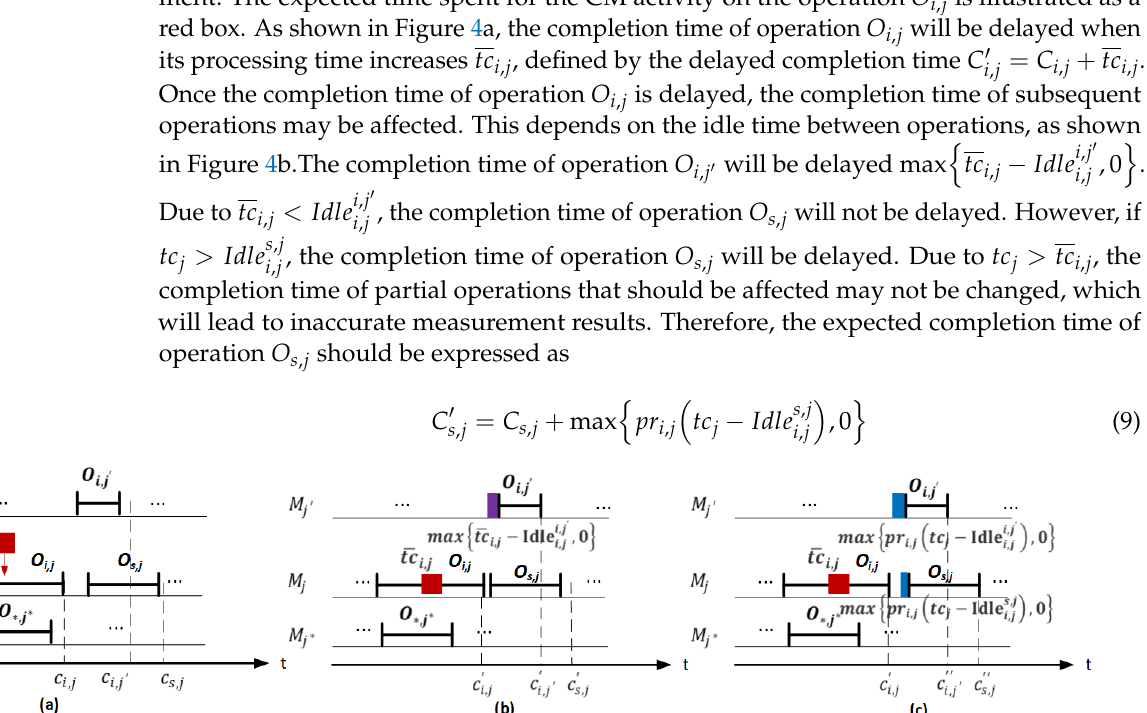
Figure 5. The Gantt chart for n = 3, m = 2. In chain 1, i.e., 𝑂 1,1 → 𝑂 3,1 → 𝑂 3,2 , when the failure occurs in the operation 𝑂 1,1 , it may first affect the completion time of operation 𝑂 3,1 . As shown in Figure 6b, the expected completion time of 𝑂 3,1 is denoted as 𝐶 3,1 Ⅰ = 𝐶 3,1 + max { 𝑝𝑟 1,1 ( 𝑡𝑐 1 − 𝑖𝑑𝑙𝑒 1,13,1 ) , 0 } . The fail- ure will continue to propagate along the chain of constraints, and the operation 𝑂 3,2 will be affected. The expected completion time of 𝑂 3,2 is 𝐶 3,2 Ⅰ = 𝐶 3,2 + max { 𝑝𝑟 1,1 ( 𝑡𝑐 1 − 𝑖𝑑𝑙𝑒 1,13,2 ) , 0 } . When the failure occurs in the operation 𝑂 3,1 , the propagation process is shown in Figure 6c. The expected delay time of 𝑂 3,2 affected by RMBs on 𝑂 3,1 is de- noted as max{𝑝𝑟 3,1 (𝑡𝑐 1 − 𝑖𝑑𝑙𝑒 3,13,2 ), 0} , where 𝑖𝑑𝑙𝑒 3,13,2 = 𝐶 3,2 Ⅰ − 𝐶 3,1 Ⅰ . When the failure occurs in the operation 𝑂 3,2 , as shown in Figure 6d, the expected delay time of 𝑂 3,2 is 𝑝𝑟 3,2 ∙ 𝑡𝑐 2 . The expected completion time of 𝑂 3,2 by affected by RMBs on the operation of chain 1 can